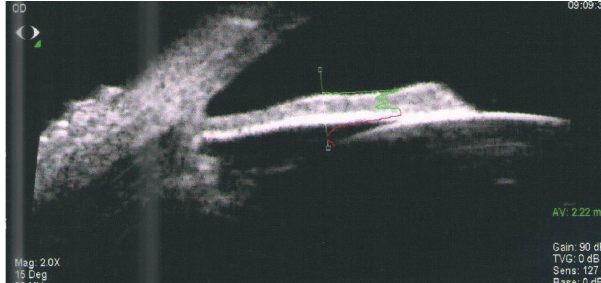
Figure 7. High resolution ultrasound biomicroscopy (UBM) of the iris, five months after brachytherapy with ru-106 plaque reveals complete tumor regression and iris atrophy.